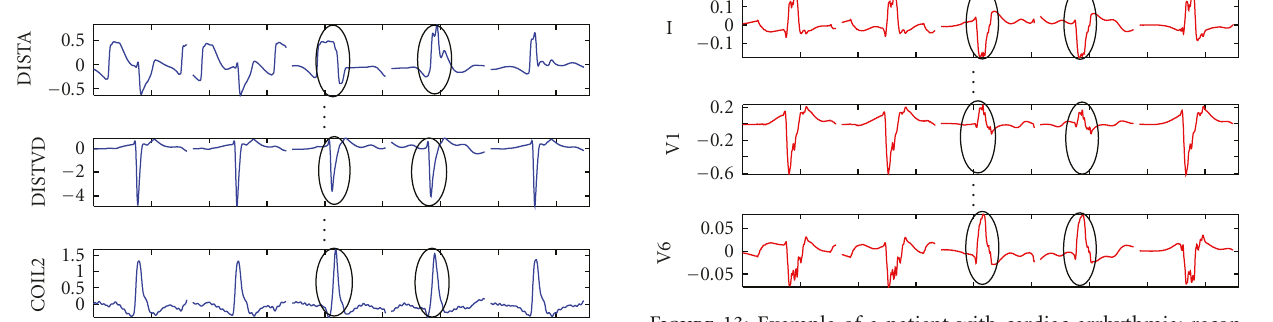
Figure 13: Example of a patient with cardiac arrhythmia: recon- structed ECG channels.